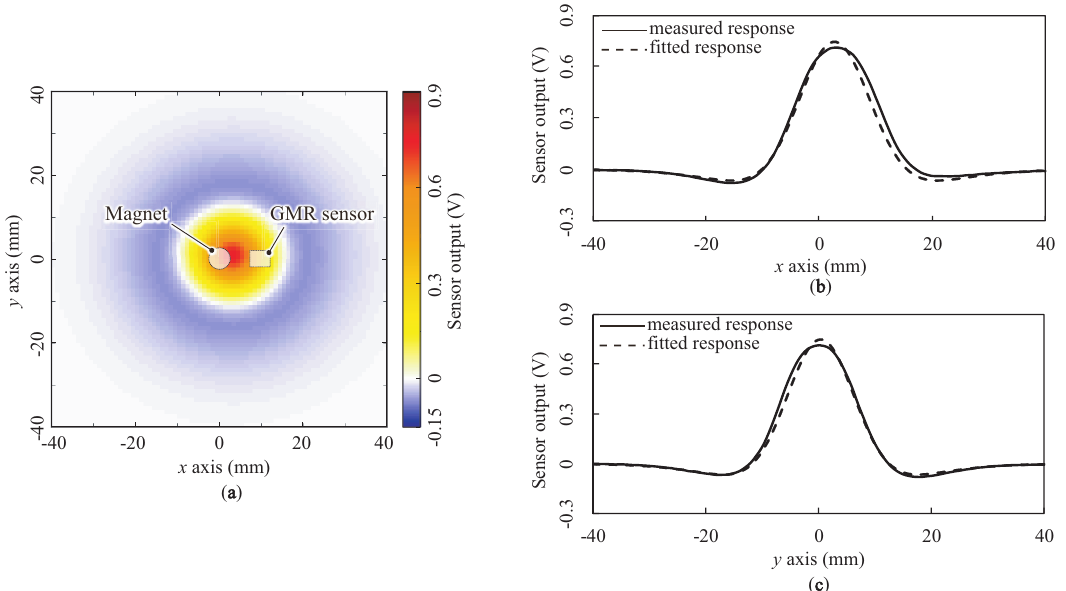
Figure 13. Comparison between the measured and fitted responses for a depth of 4 mm: ( a ) two-dimensional fitted response and ( b , c ) line profiles along the x and y axes through the center ( x o , y o ) = (0, 0),